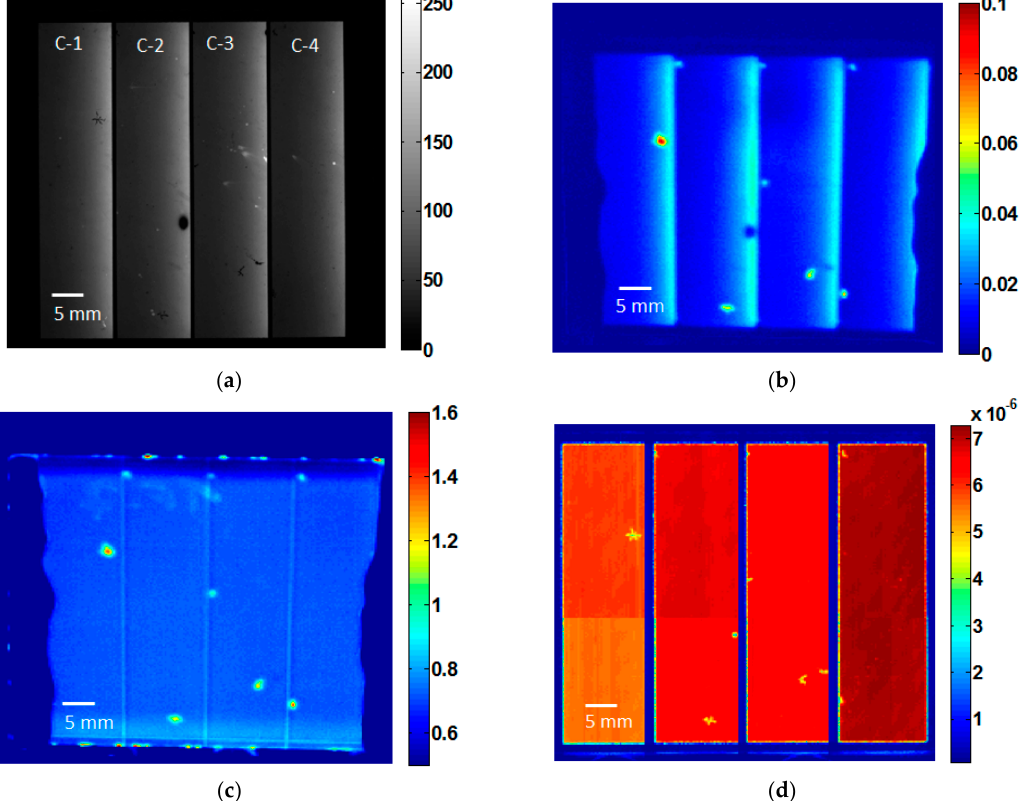
Figure 11. ( a ) EL at J sc ; ( b ) DLIT; ( c ) V oc -ILIT; and ( d ) li -LBIC images of TF-4 module.